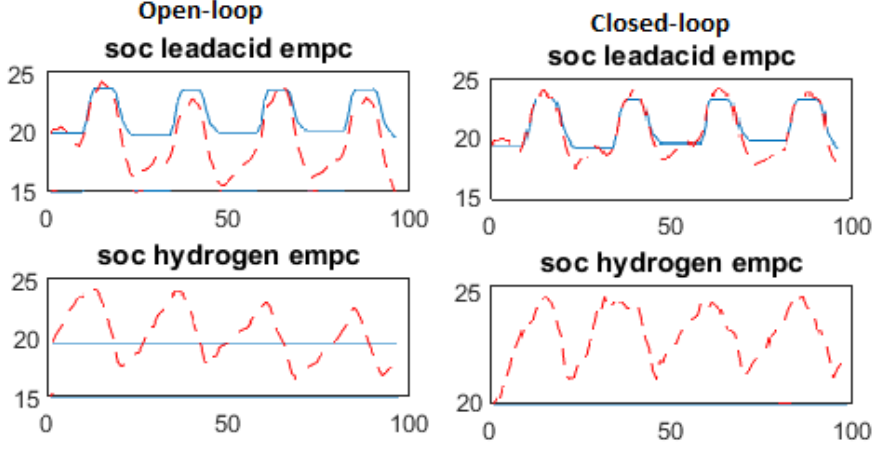
Figure 6. Sample winter plots of batteries’ State of Charge.